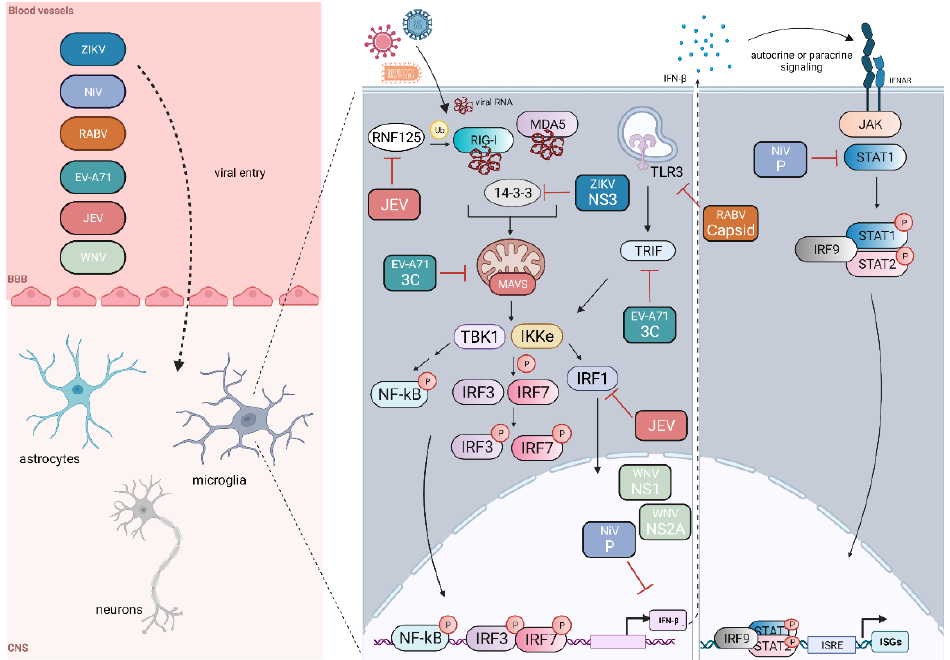
Figure 2. Neurotropic RNA virus evasion of IFN- β induction and responses in the CNS. Several RNA viruses can bypass the blood – brain barrier (BBB) through the circulatory system and enter the cells of the central nervous system (CNS). We also note that viral entry into the CNS may occur through other routes in addition to the circulatory vessels depicted within microglia; these viruses can block (red inhibitory arrows) components of the RIG-I signaling pathway, blocking IFN- β induction and subsequent JAK-STAT interferon signaling. Black arrows indicate subsequent steps within the signaling pathway or translocation from the cytoplasm to the nucleus. Created with BioRender.com.